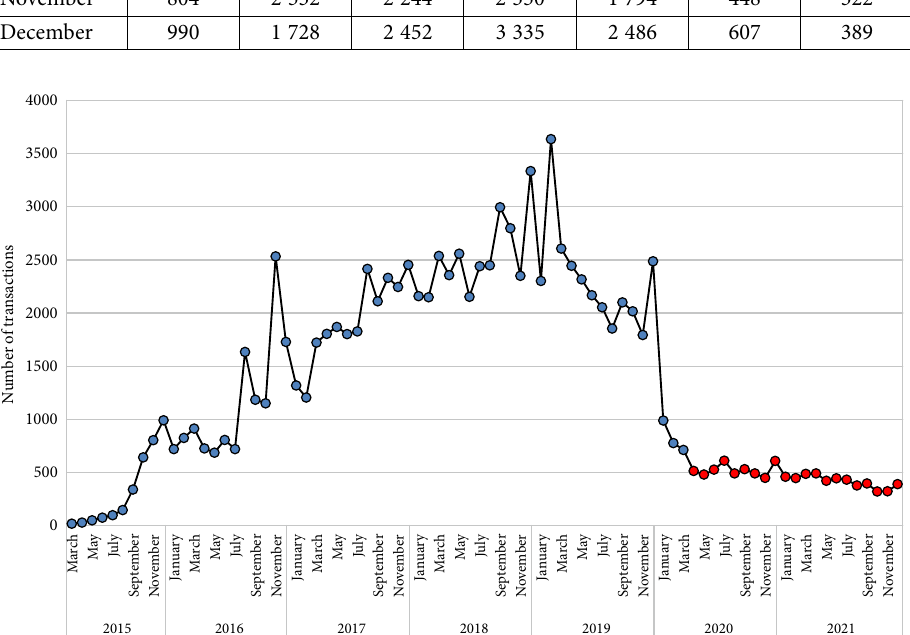
Figure 3. Number of transactions carried out in the system between 2015 and 2021 (in Zielony) (source: own elaboration based on Stępnicka et al., 2021; data obtained from the administrator of the Zielony complementary currency system